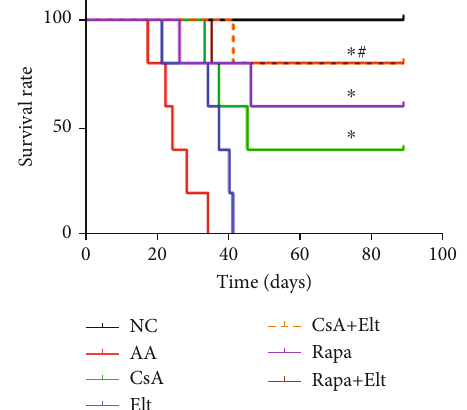
Figure 9: The survival rate of AA mice improved after the treatment of rapamycin combined with eltrombopag. ∗ Compared with the AA group ( P < 0 : 05 ). # Compared with the Rapa group ( P < 0 : 05